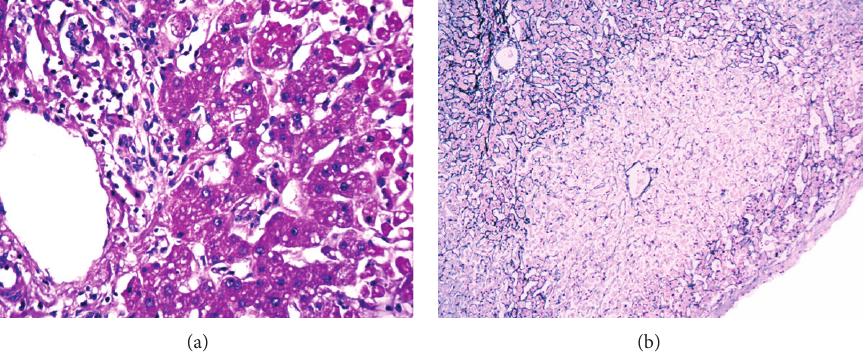
Figure 1: Confluent centrilobular necrosis with reticulin collapse, as well as inflamed portal tracts with and active necroinflammatory tissue. (a) Hematoxylin eosin staining of the transition zone. (b) Gomori silver staining that shows central necrosis in a panoramic